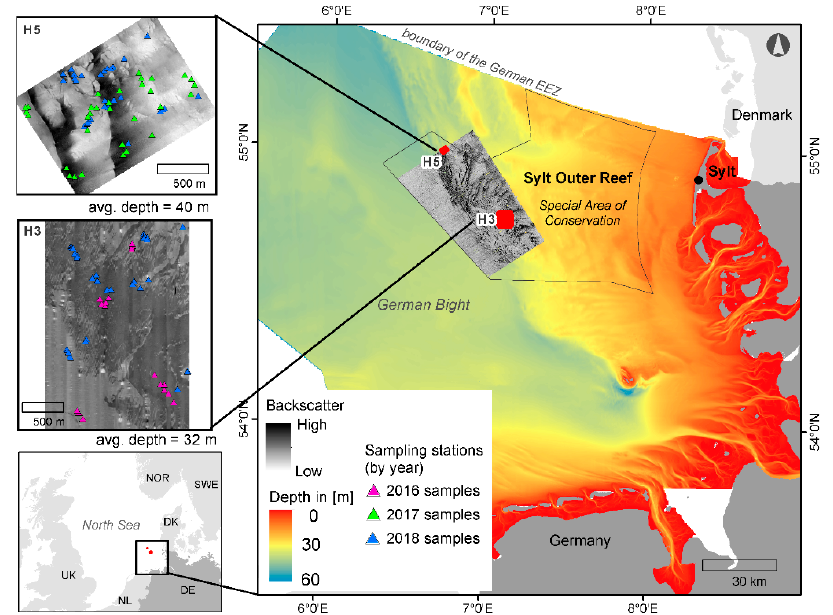
Figure 1. The study sites are in the western side of the Sylt Outer Reef, a Special Area of Conservation. The maps ( left ) show the two focus areas and the location of the sampling stations between 2016 and 2018.